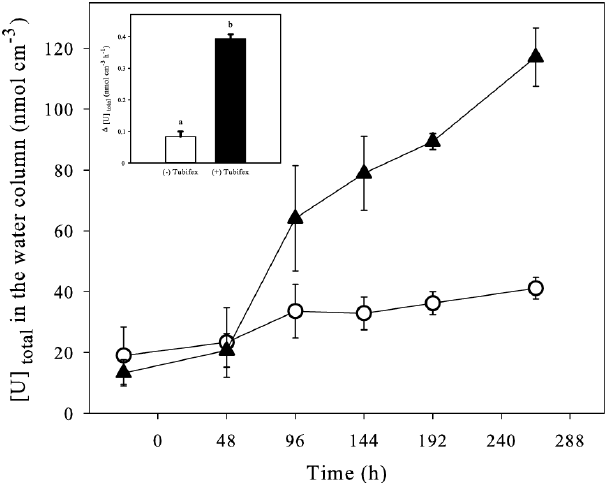
Figure 1. Temporal variation of total U concentration in the wa- ter column, without ( (cid:13) ) and with ( N ) T. tubifex worms inhabiting the sediment. The inset bar chart shows the net accumulation rate of U after 288h (12 days). Means ± SD ( N = 3). The data corre- sponding to control (i.e. uncontaminated) treatments are not plotted (concentrations below the detection